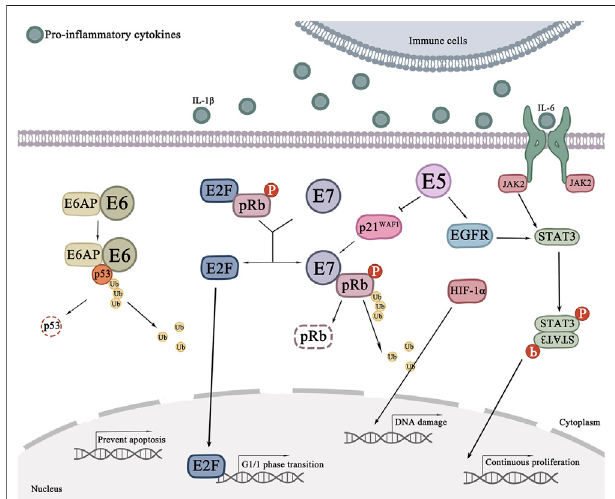
FIGURE 3 | Signaling pathways in the development stage of cervical cancer cells. E7 oncoproteins binds to the PRB-E2F complex, a step that separatesE2FfrompRb.InthecaseofhighE2Fexpression,cellswillpassthe G1/S phase and pRb will eventually be degraded by the proteasome. The STAT3 signaling pathway can be activated by IL-6 to promote cell proliferation which can also be induced by HIF-1 α , E5 can inhibit the expression of p21 WAF1 , thus promoting the separation of E2F from pRb, and regulate STAT3 by regulating EGFR.